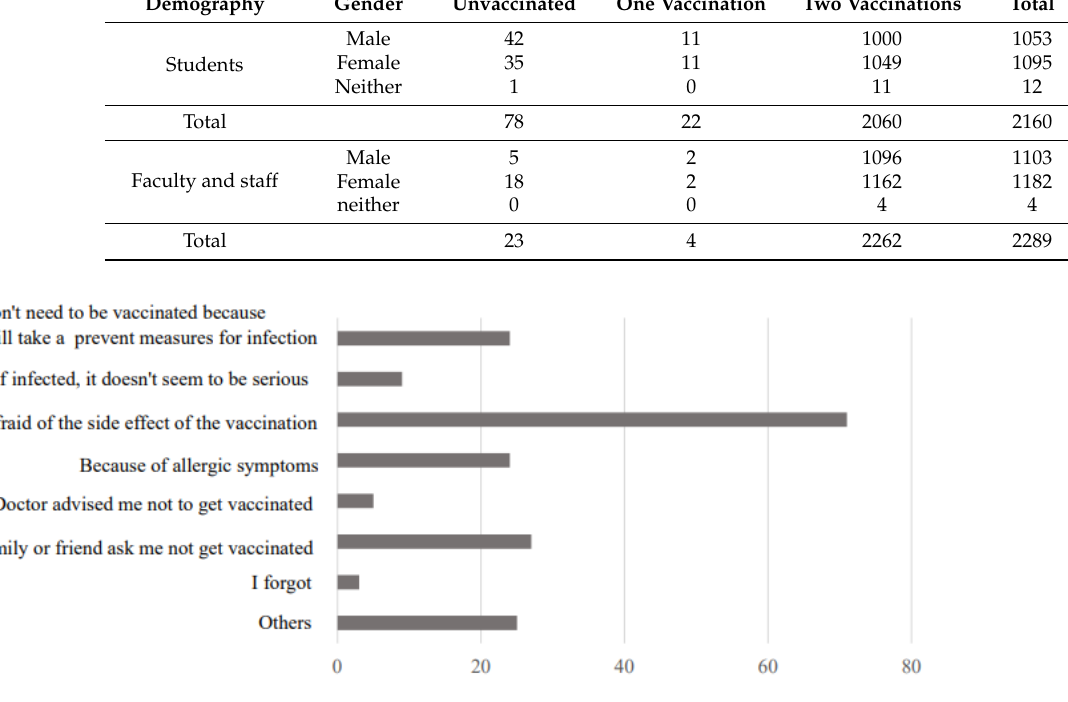
Figure 1. Reasons for not vaccination (multiple answers).